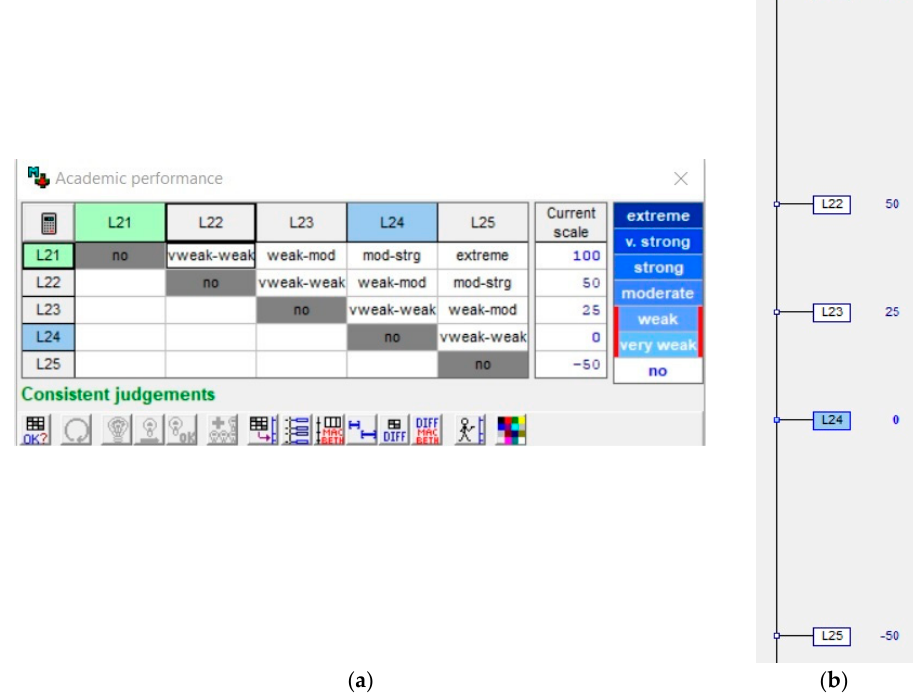
Figure 4. ( a ) MACBETH judgement matrix of the Academic performance criterion; ( b ) value